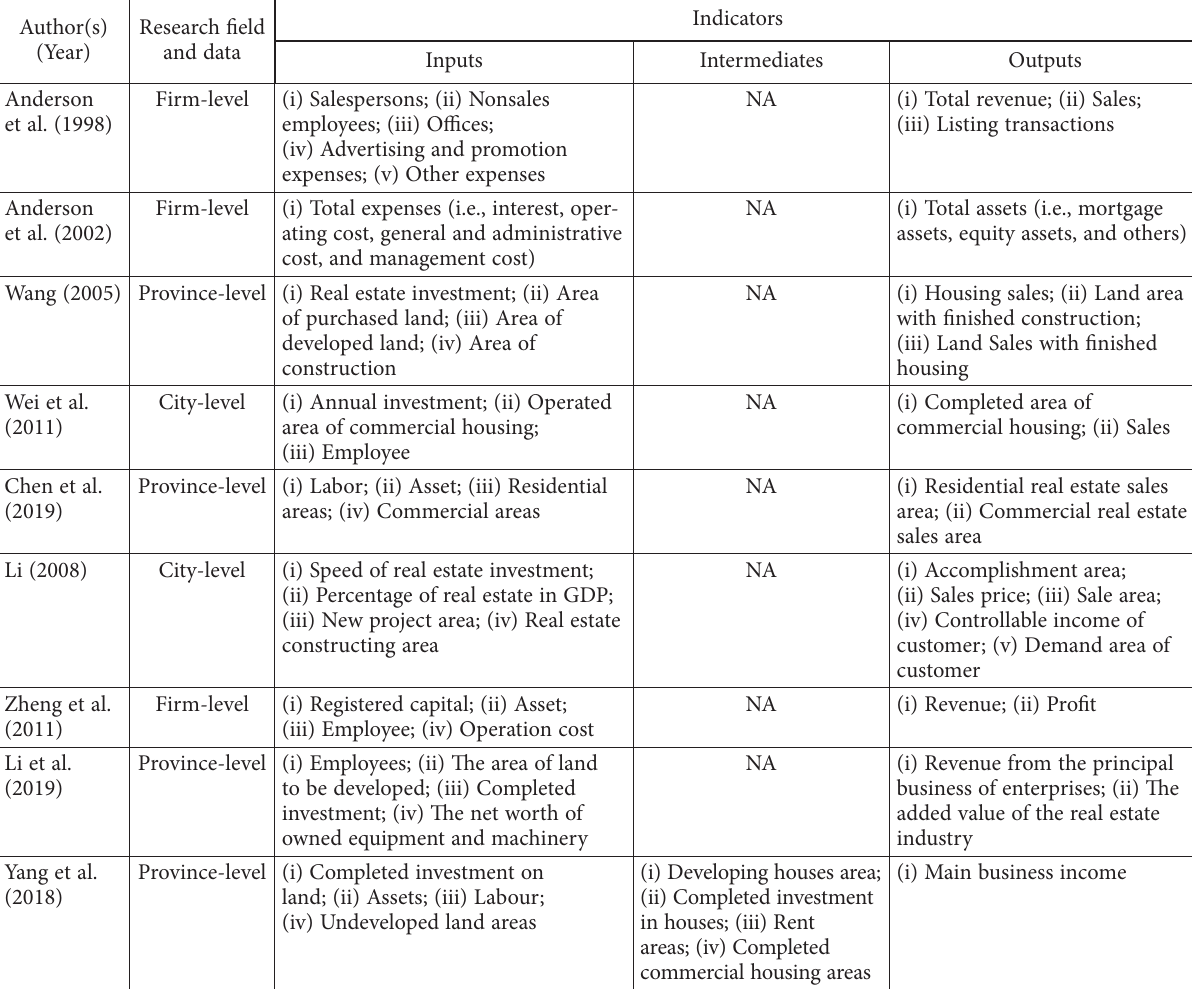
Table 1. A summary of the previous indicators selected in the real estate sector